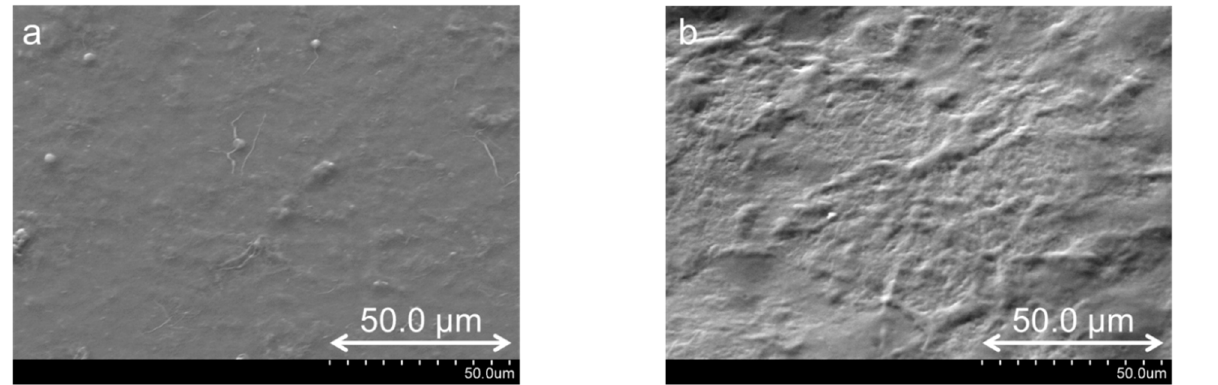
Figure A5. SEM images (top view) of ( a ) PDDA-PSS-PDDA-Laponite 160 layers and ( b ) PDDA-PAA-PDDA-Laponite 160 layers.